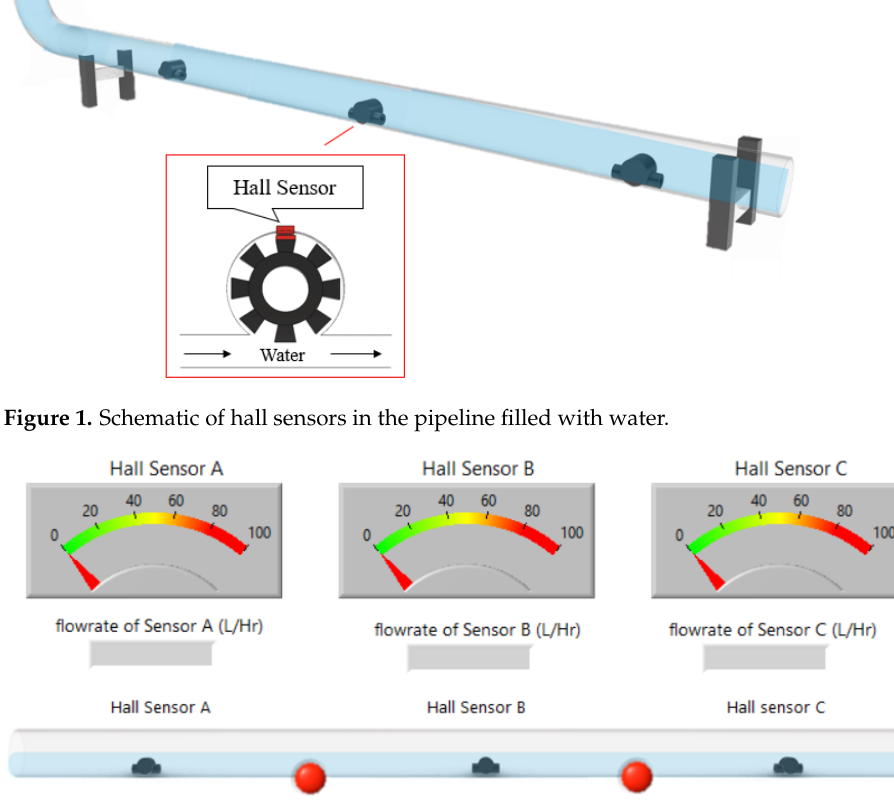
Figure 1. Schematic of hall sensors in the pipeline filled with water.